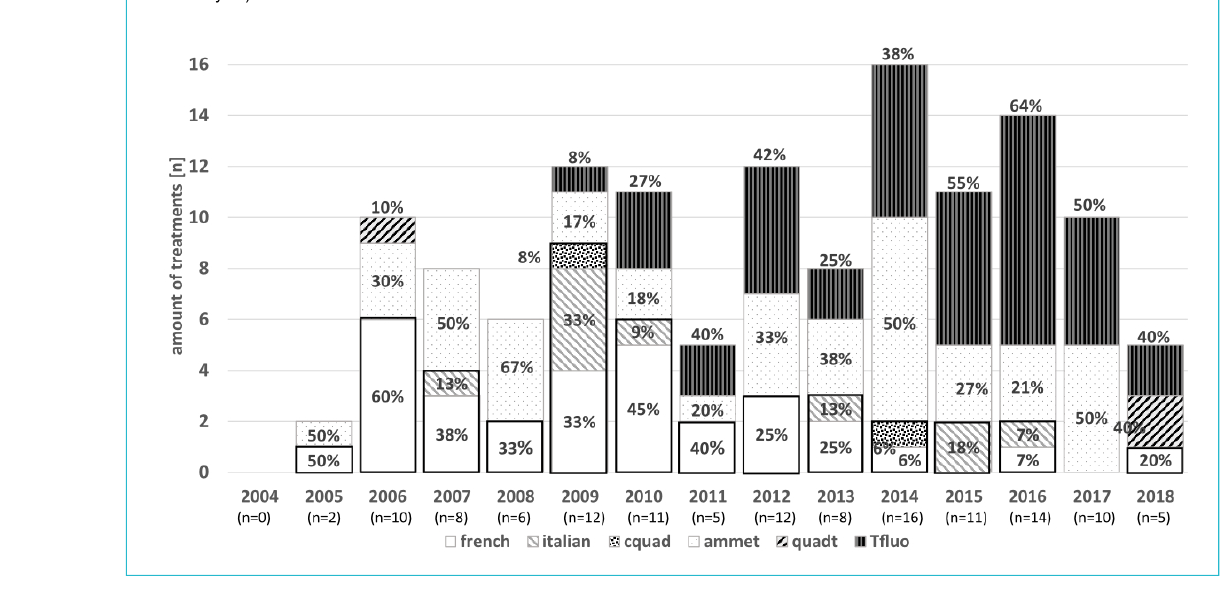
Figure 4: Different second-line Helicobacter pylori eradication therapy regimens over the years. french: PPI-amoxicillin-clarithromycin*; ital- ian:PPI-metronidazole-clarithromycin*; cquad:PPI-clarithromycin-amoxicillin-metronidazole*;